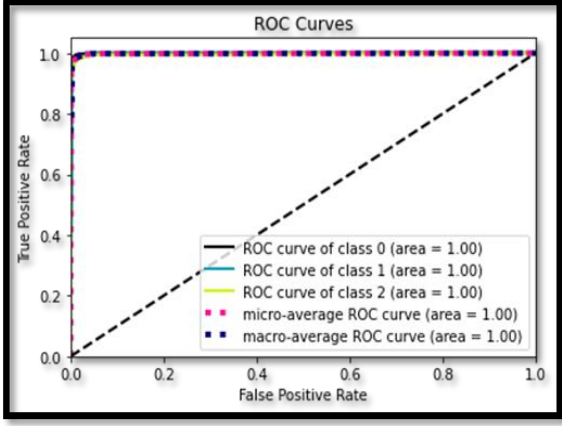
Fig. 6. Statistical data of confusion matrix on potato dataset